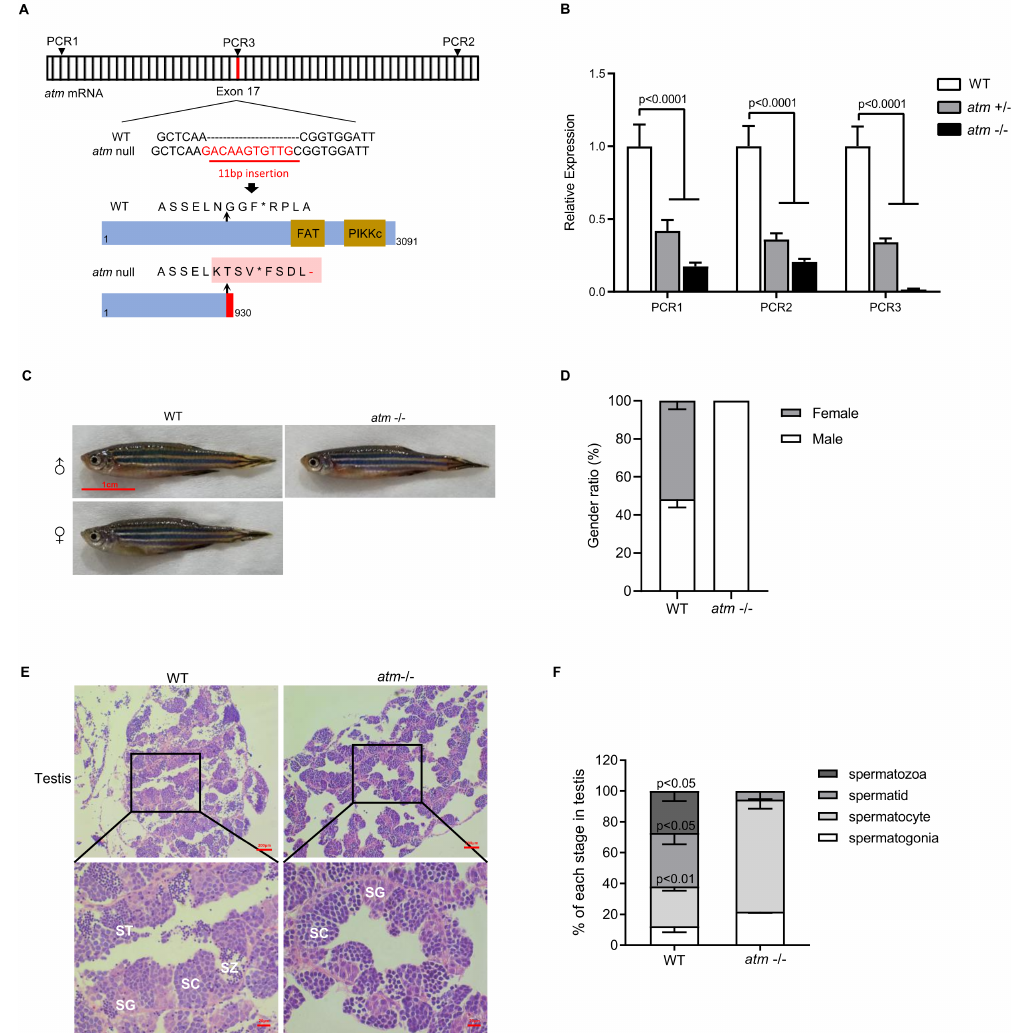
Figure 1. Mutant schema of atm and infertility phenotype. ( A ) Cas9-based engineering system of the atm introduced a stop code before functional domain. ( B ) Relative expression level of atm mRNA at different location (shown in ( A )) of atm +/ − and atm − / − zebrafish compared to WT (n = 3). ( C ) General observation of wild-type and atm − / − zebrafish at 6 months old. ( D ) Gender ratio of atm − / − compared with WT zebrafish (Over 50 fish each group were calculate). ( E ) HE stains of testis. SG, spermatogonia; SC, spermatocyte; ST, spermatid; SZ, spermatozoa. ( F ) Ratio of each stage of meiosis in atm − / − zebrafish testis compared to WT (n = 3). The statistical significance was analyzed using the two-tailed Student’s t-test. Data are shown as means ±